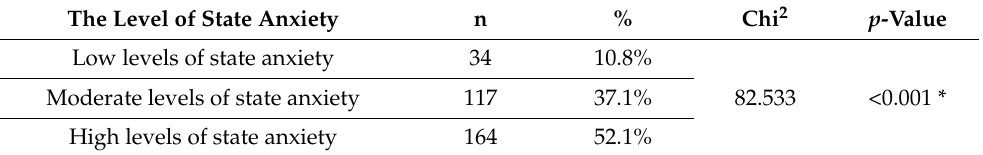
Table 4. The level of state anxiety according to STAI inventory (n = 315). The Level of State Anxiety